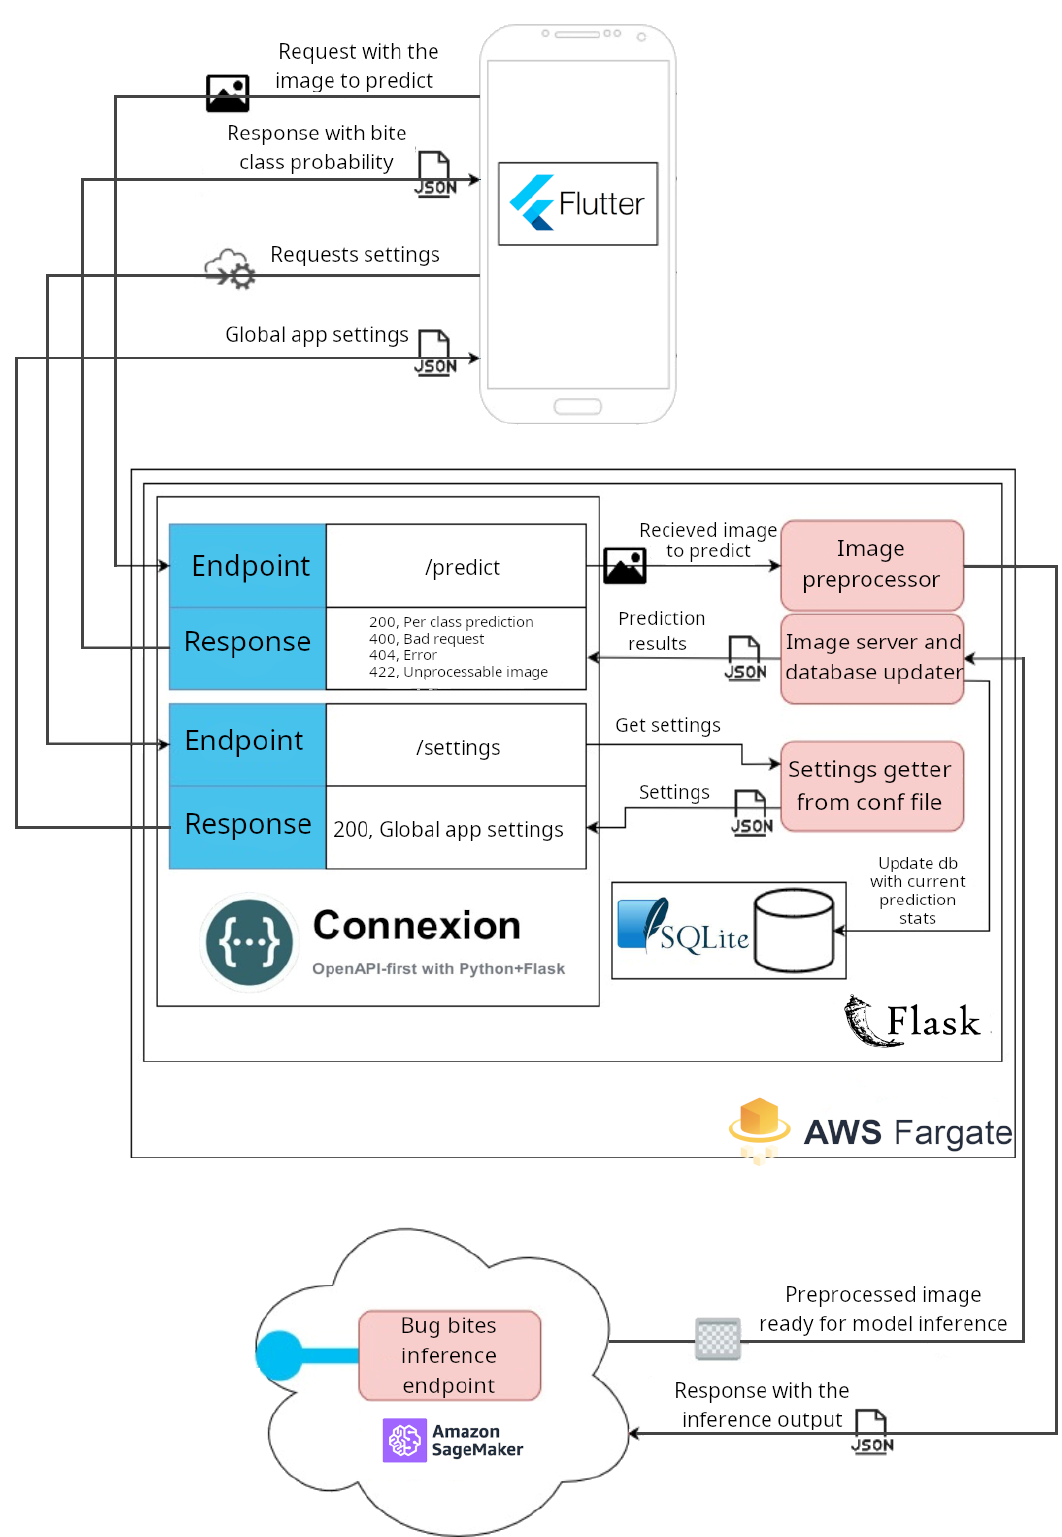
Figure 9. Back-end